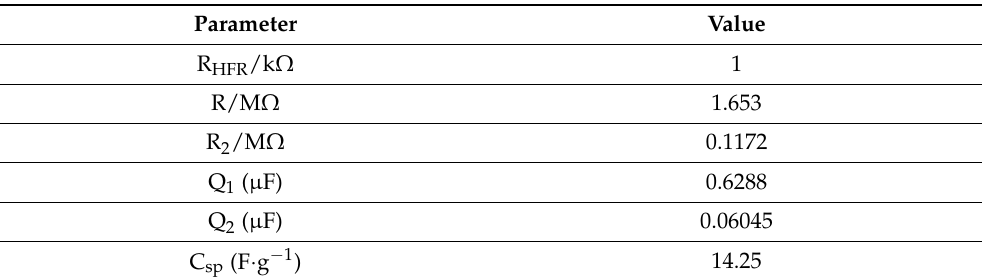
Figure 13. Experimental impedance and EEC fitting plot for the high conducting PE; PVA: PVP (50:50 wt%) + 20 wt%NasCN. Table 4. Values of electrical parameters were recorded from fitting data via Origin Pro 8.0 by using the extrapolation method [39].